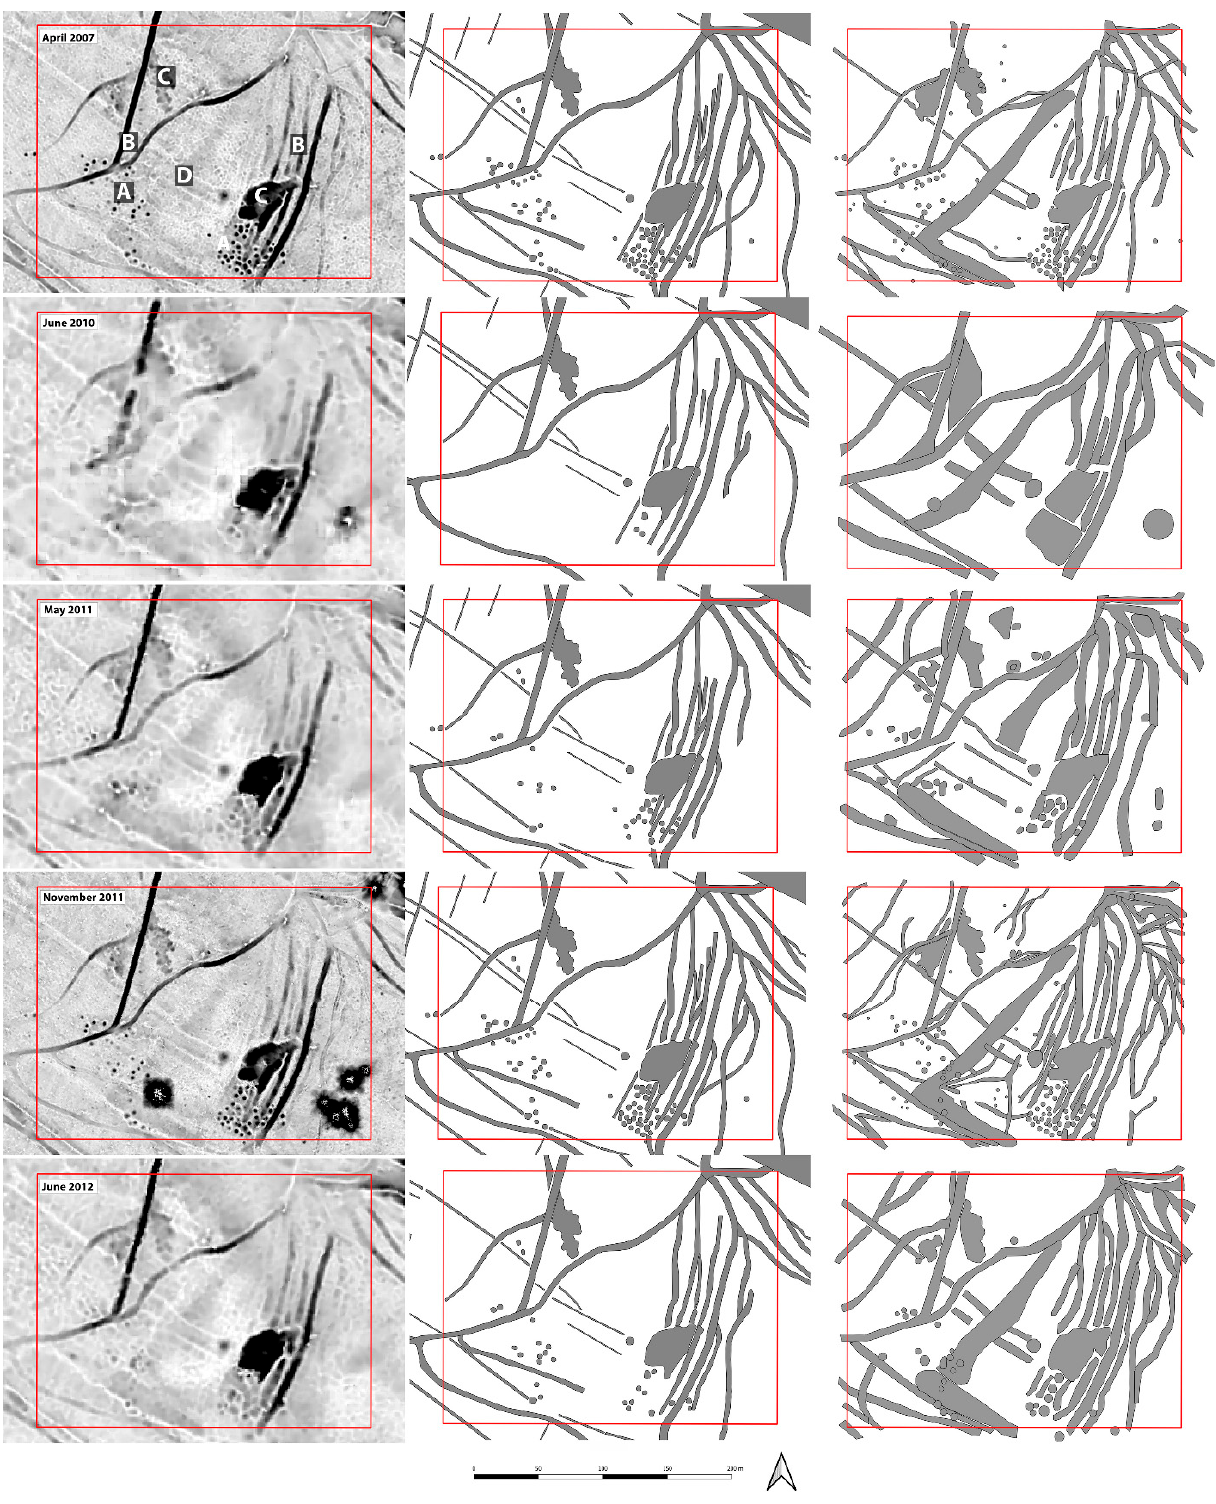
Figure 15. Area 4. The columns represent a visualisation of the dataset using positive openness with colour gradient black to white, stretch to min–max min. 1.41–max. 1.58 ( left ), results of the “copied interpretation” ( centre ), and results of the “individual interpretation” ( right ). The rows correspond to the individual datasets as indicated for each row in the left image. The red box represents the boundary of the sample area. The letters in the upper left image refer to the text.